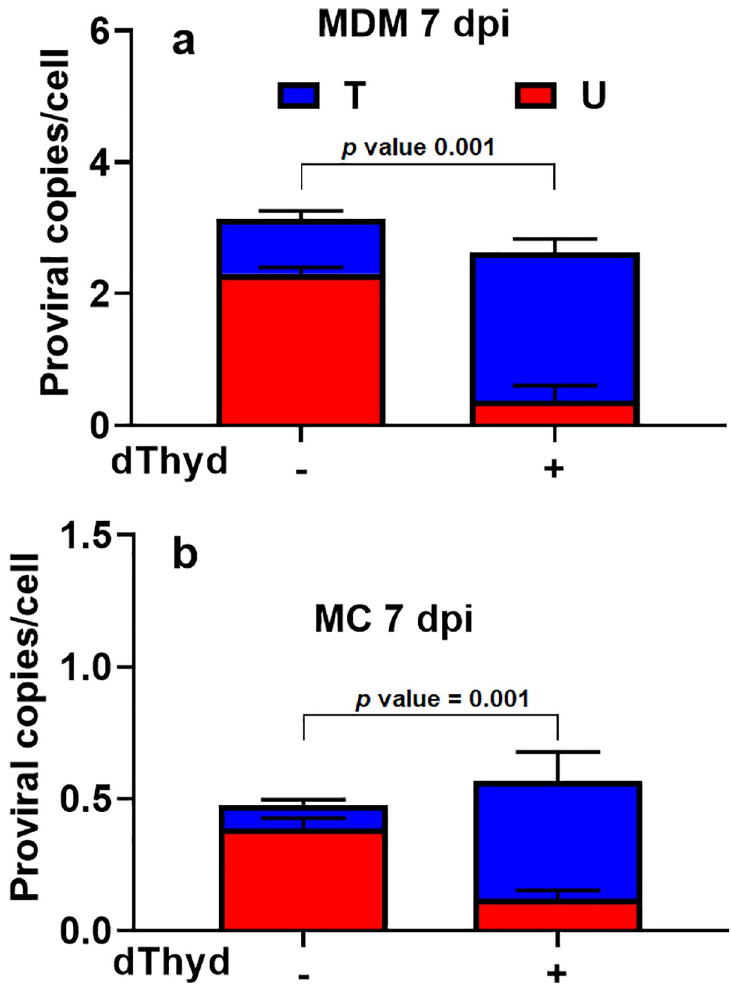
Fig 4. dUMP in HIV DNA during infection of MC and MDM arises predominantly from dUTP. MC and MDM LI were infected with HIV-1 Bal virus at an MOI of 5 (1 pg p24/cell) in the presence (+) and absence (-) of 5 mM deoxythymidine (dThyd). Copy number measurements of uracilated (red) and non-uracilated (blue) proviruses were made 7 dpi using the Alu-gag Ex-qPCR method. (a) MDM LI and (b) MC infected in the absence and presence of dThyd. p -values from an unpaired Student’s t -test are